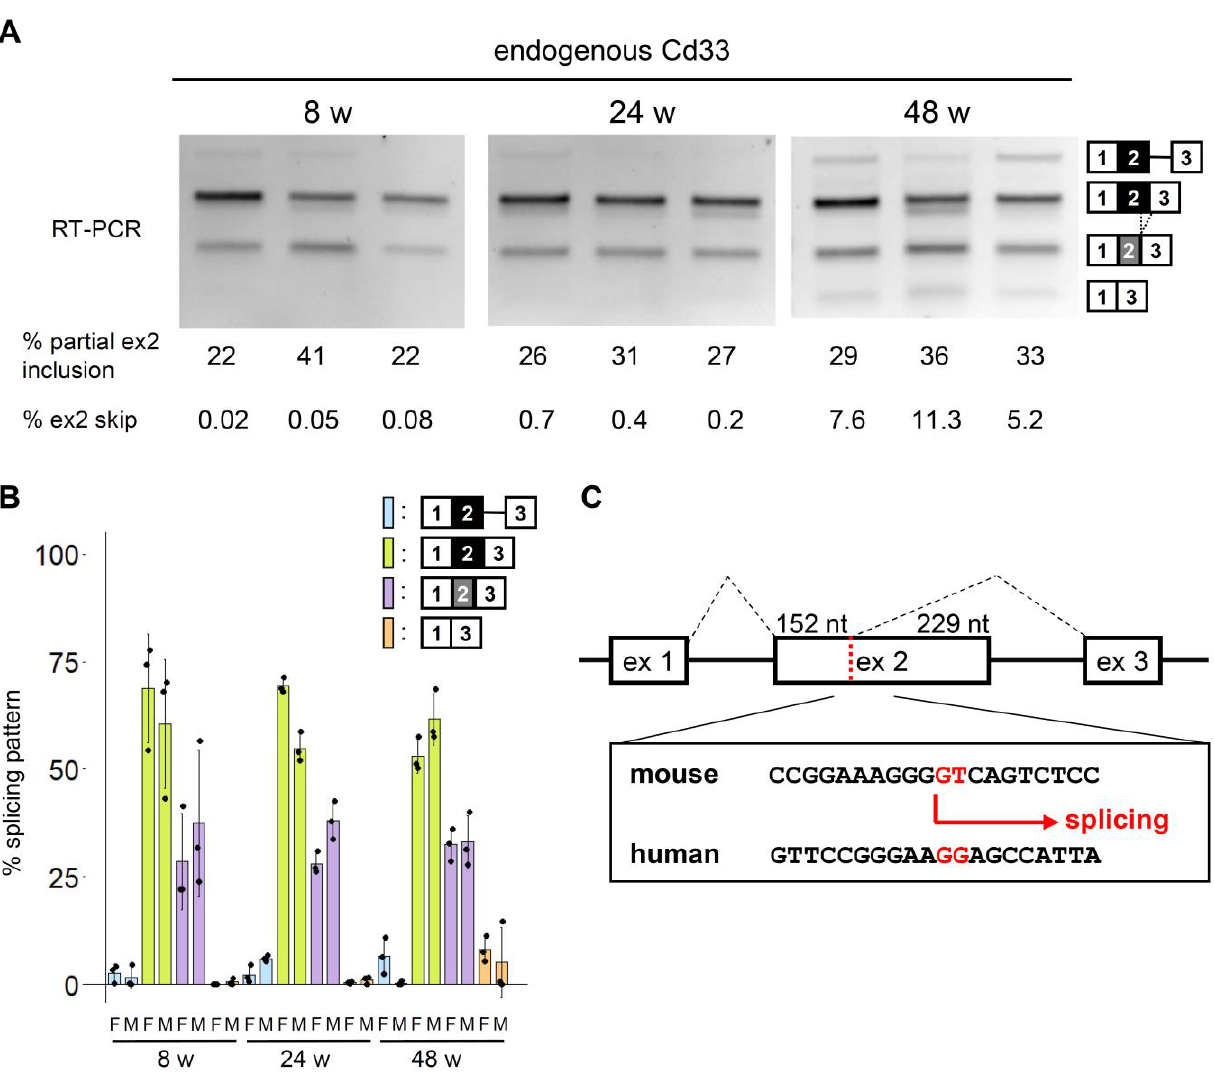
Figure 5. Splicing of Cd33 in mouse brain. ( A ) Splicing assay of mouse Cd33 in the hippocampus of female mice of different ages. ( B ) Quantification of the splicing patterns of Cd33 in female and male mice. Error bars represent SD ( n = 3). ( C ) Comparison of the exon 2 sequences of human and mouse CD33 genes. Mouse Cd33 contains a GT dinucleotide that constitutes a cryptic 5′ splice site.